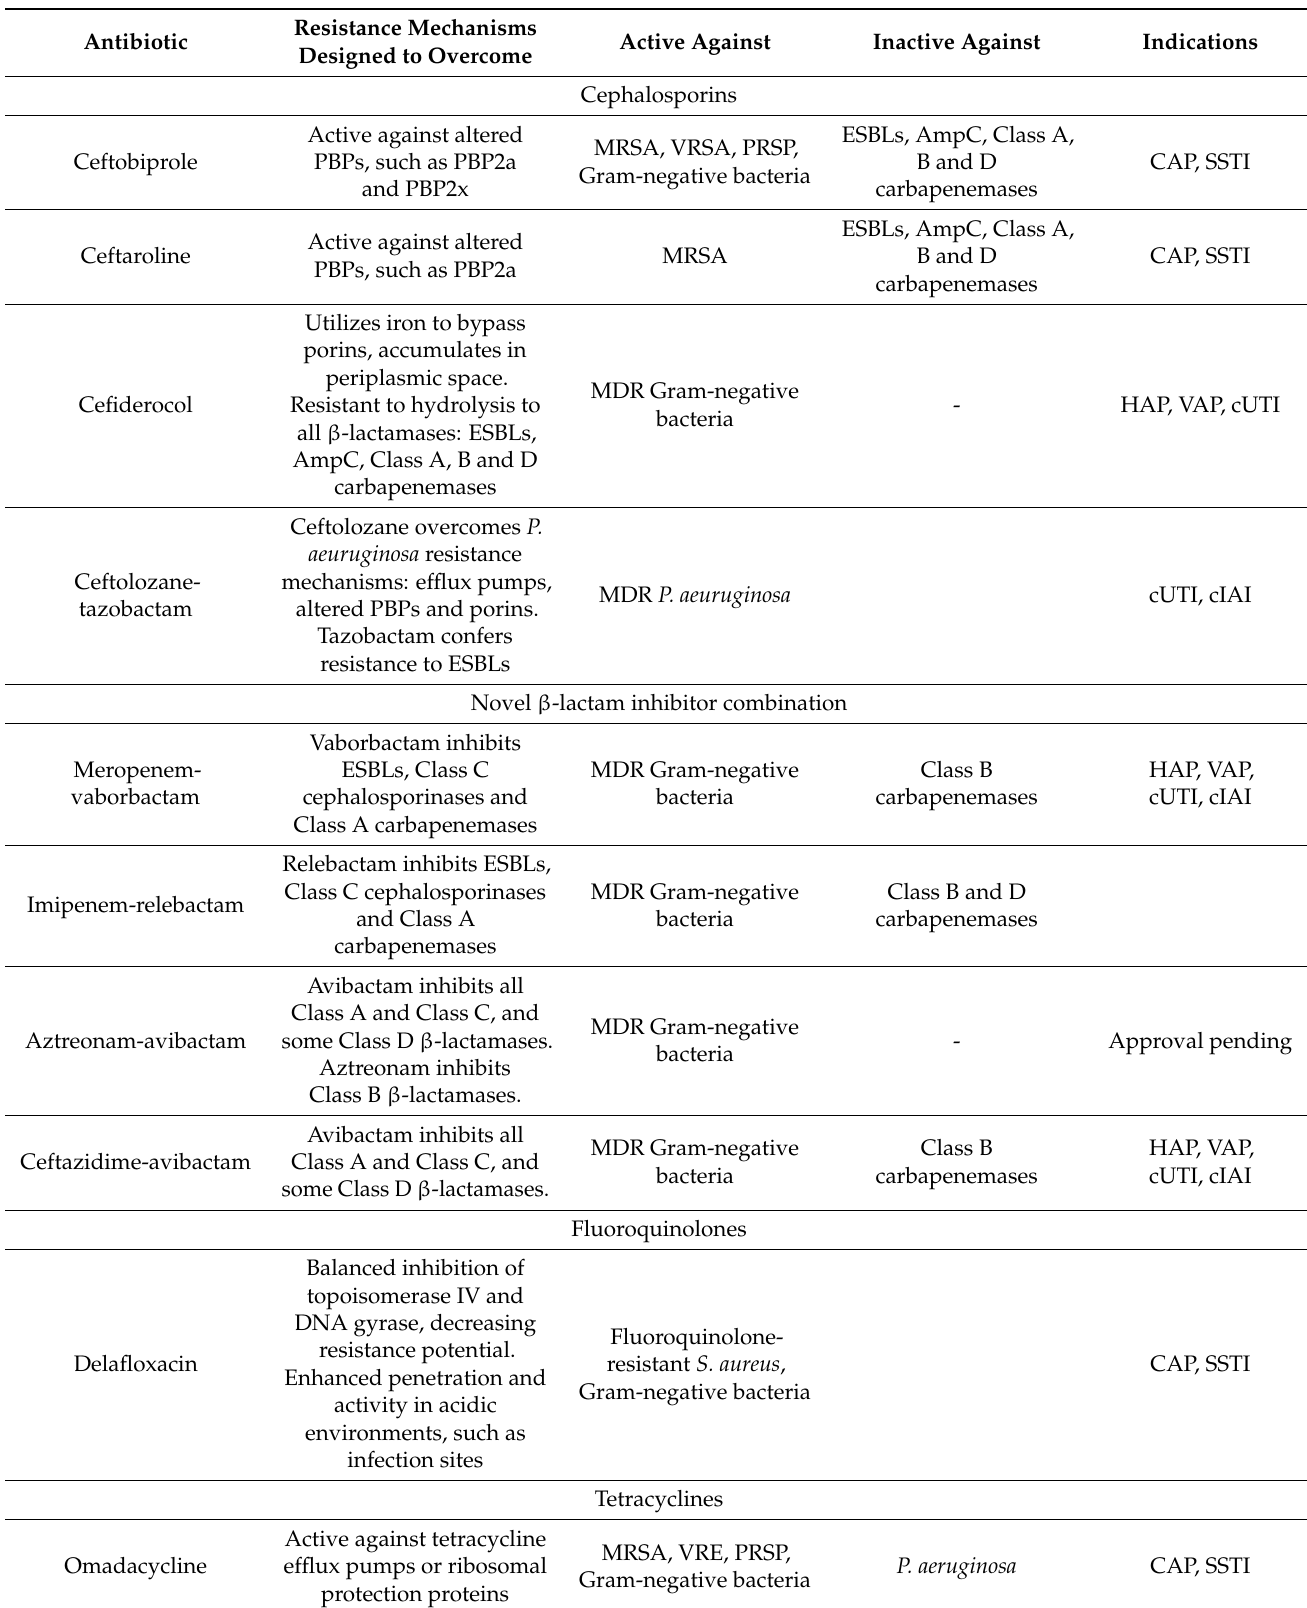
Table 4. Novel antibiotics, mechanisms of overcoming resistance and spectrum of activity.